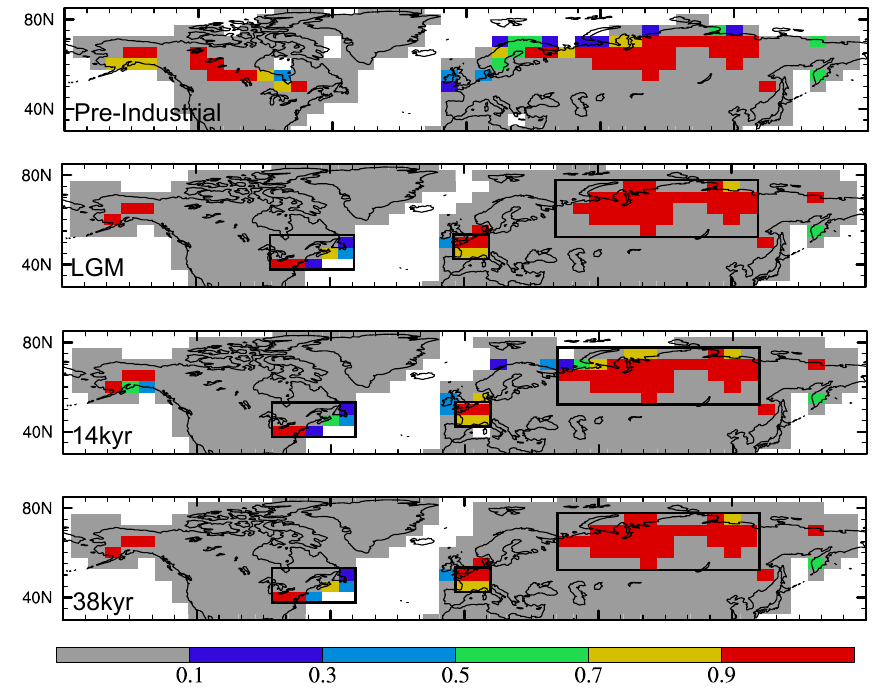
Fig. 4. Prescribed peat grid cells in the pre-industrial, LGM, 14 and 38kyr simulations. Boxes indicate area of peat removed (for Siberia) or additionally prescribed (for western North America and Europe) as summarised in Table 3.